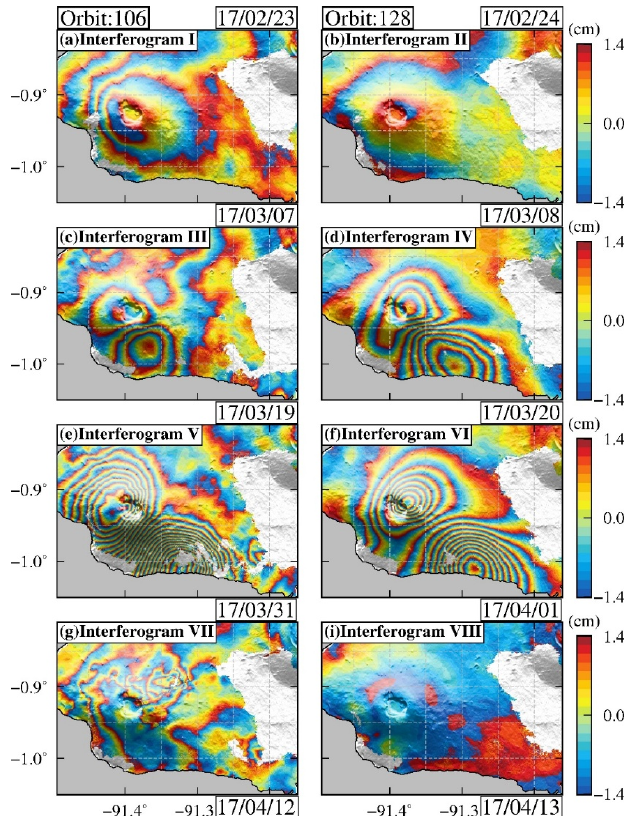
Figure 2. Wrapped surface deformation fields from Sentinel-1A satellite in the Cerro Azul volcano area from 23 February to 13 April. Every interferometric fringe indicates a displacement of 2.8 cm in the LOS direction. The left column shows differential interferograms from the ascending satellite observations, while the right column shows the descending observations. The top and bottom dates are the observation time for the master and slave images in pairs, respectively.